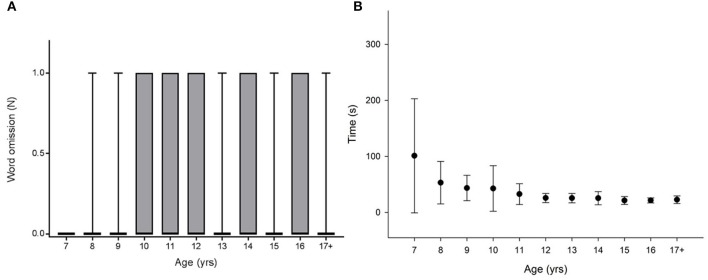
No age related difference was found for (A) the number of omitted word [Kruskal Wallis: χ2(10, N = 134) = 10.072; p = 0.434]. A significant difference between age groups was observed for (B) the reading time [Kruskal-Wallis Chi square: χ2(10, N = 134) = 95.065; p < 0.001; post hoc pairwise comparison: 7 years vs. 12–17+ years: p < 0.001).